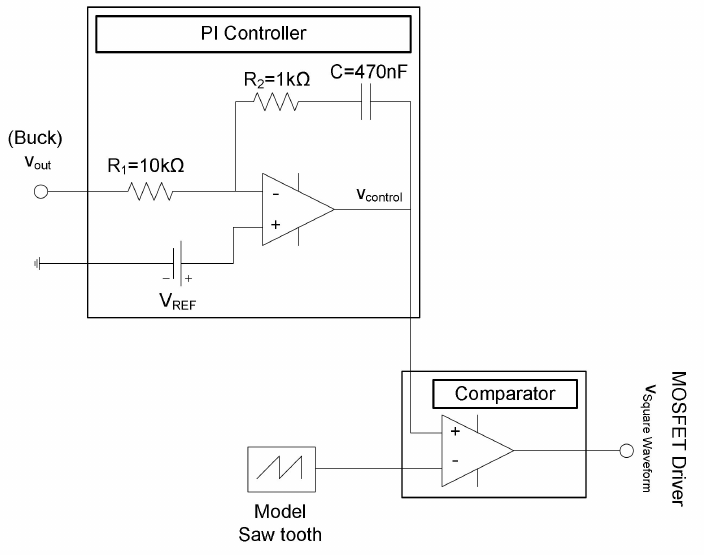
Figure 8. Schematics of the control circuit.